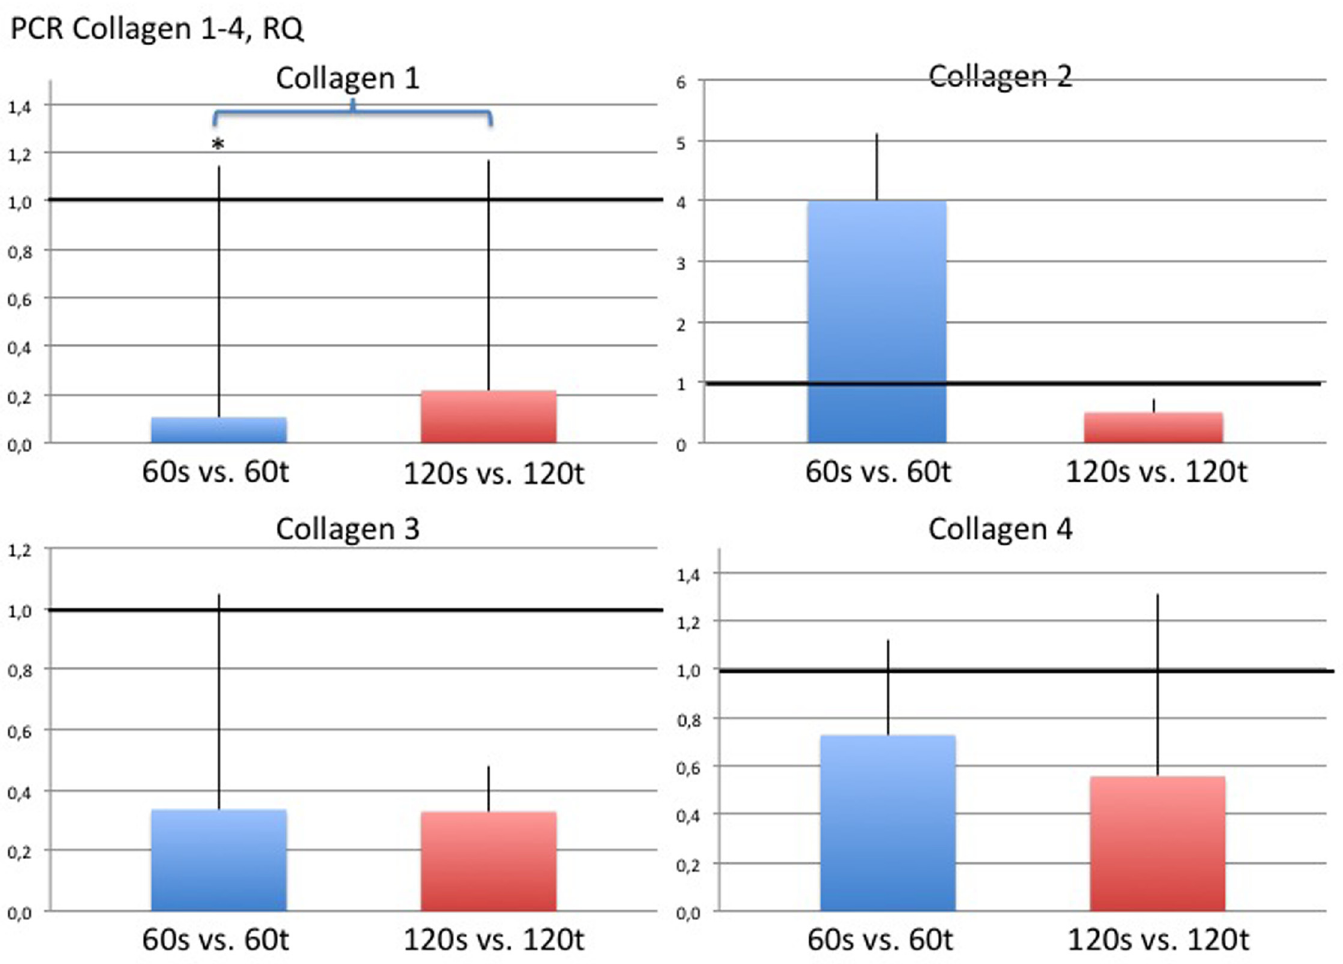
Fig 14. Results of quantitative real time PCR for Collagen 1 (upper left), 2 (upper right), 3 (lower left) and 4 (lower right) given in fold change compared to textured implant group of day 60 or 120, respectively. Asterisks and brackets indicate statistical significance and P < 0.05 was considered statistically